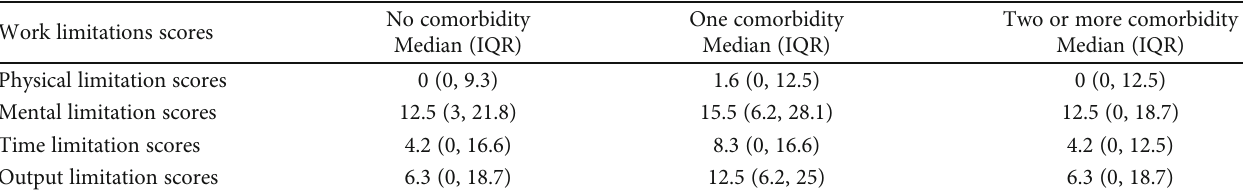
Table 3: Median and interquartile range (IQR) work limitation scores.